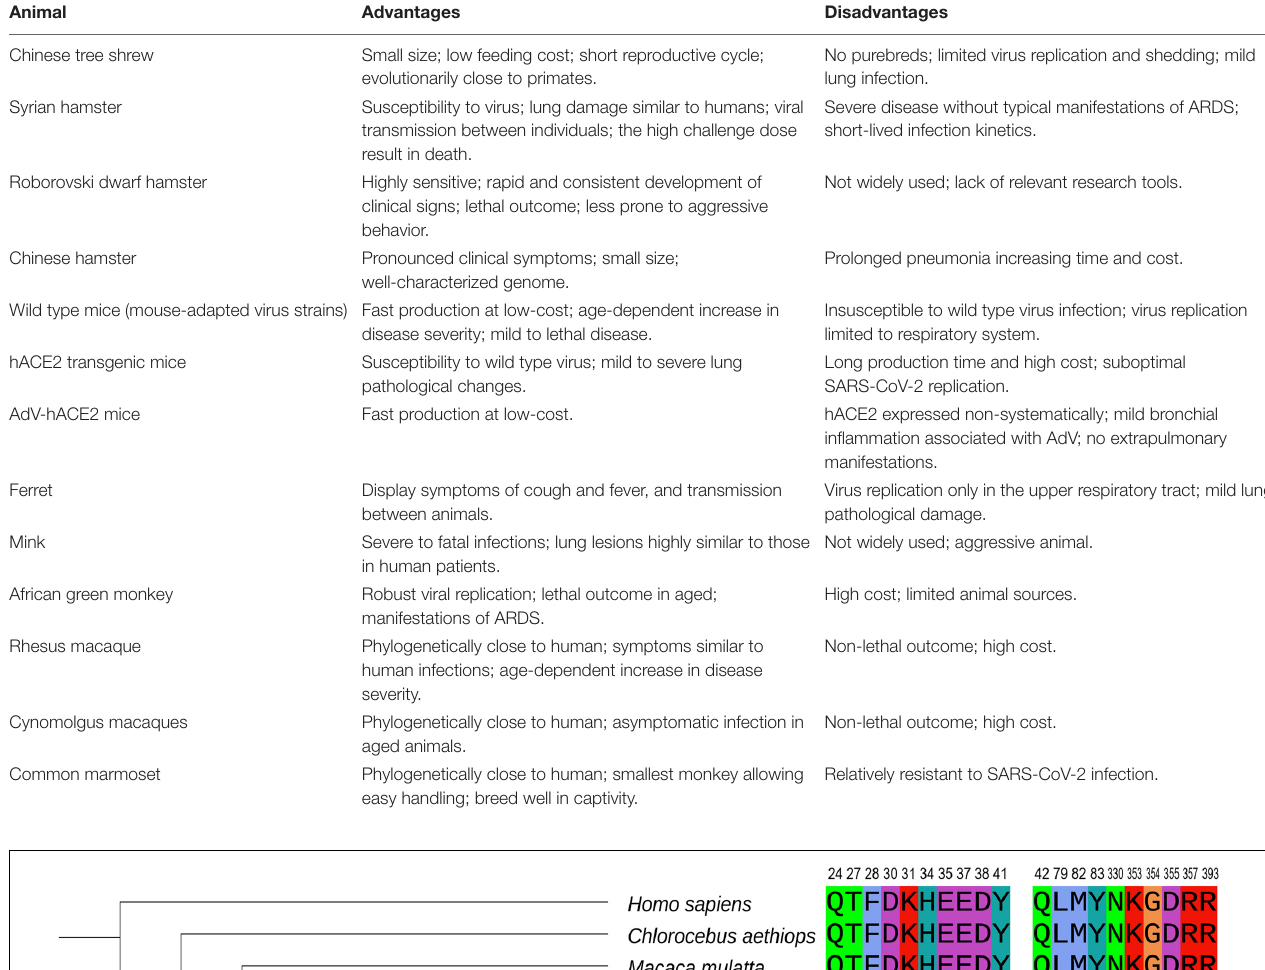
TABLE 2 | Advantages and disadvantages of SARS-CoV-2 animal models. Animal Advantages Disadvantages